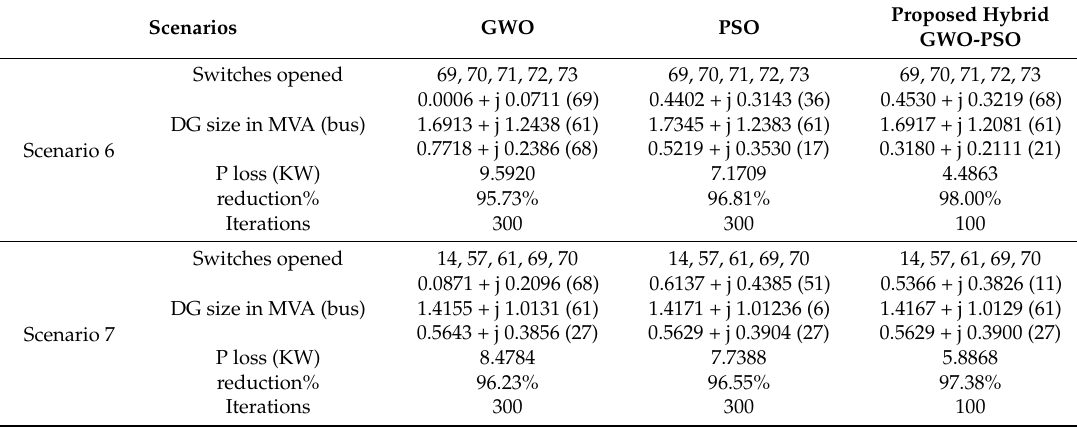
Figure 8. Single line diagram of the 69-bus system for scenario 8. Table 6. Comparison of simulation results for PQ + -type DG units of the 69-bus system.